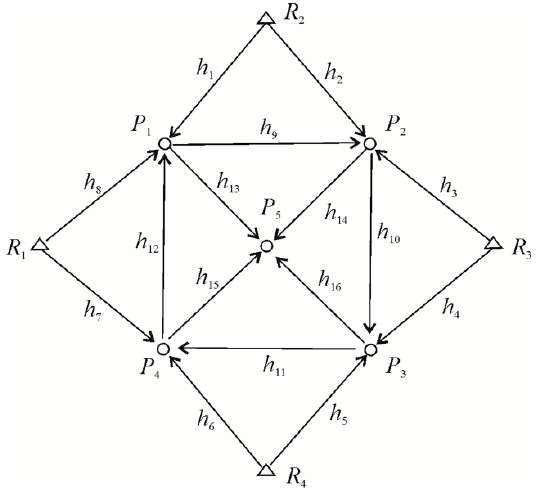
Figure 5. Tested leveling network.